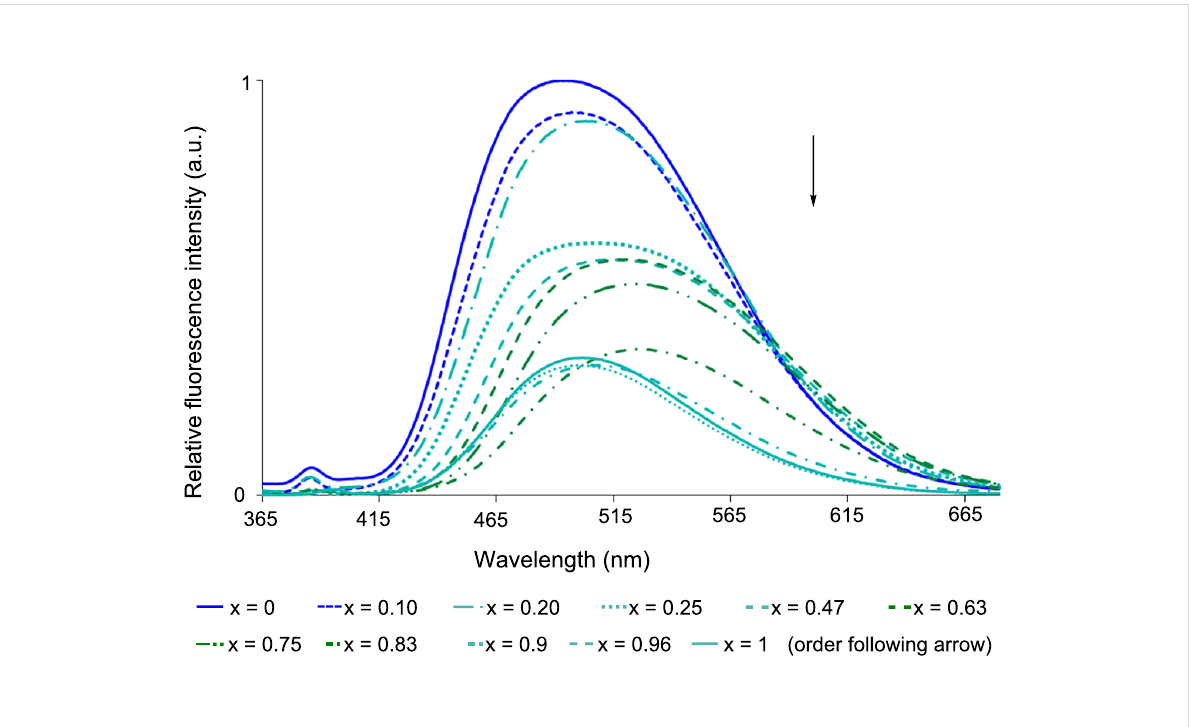
Figure 4: Emission spectra ( λ exc = 347 nm) of compound 10 in mixtures water/dioxane with different molar fractions of water (x) in 1,4-dioxane.